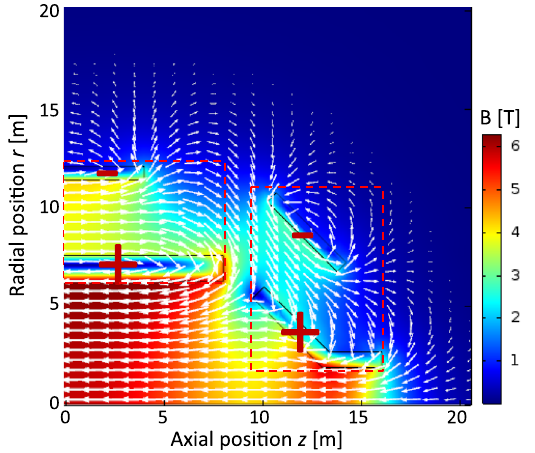
FIG. 10. Two-dimensional axisymmetric representation show- ing half of the main detector magnet and the forward solenoidal magnet. The arrows and colors indicate the magnetic field orientation and magnitude, respectively. The plus and minus signs in the superconducting coils indicate the direction of the current, while the red dotted lines indicate the common cold masses.